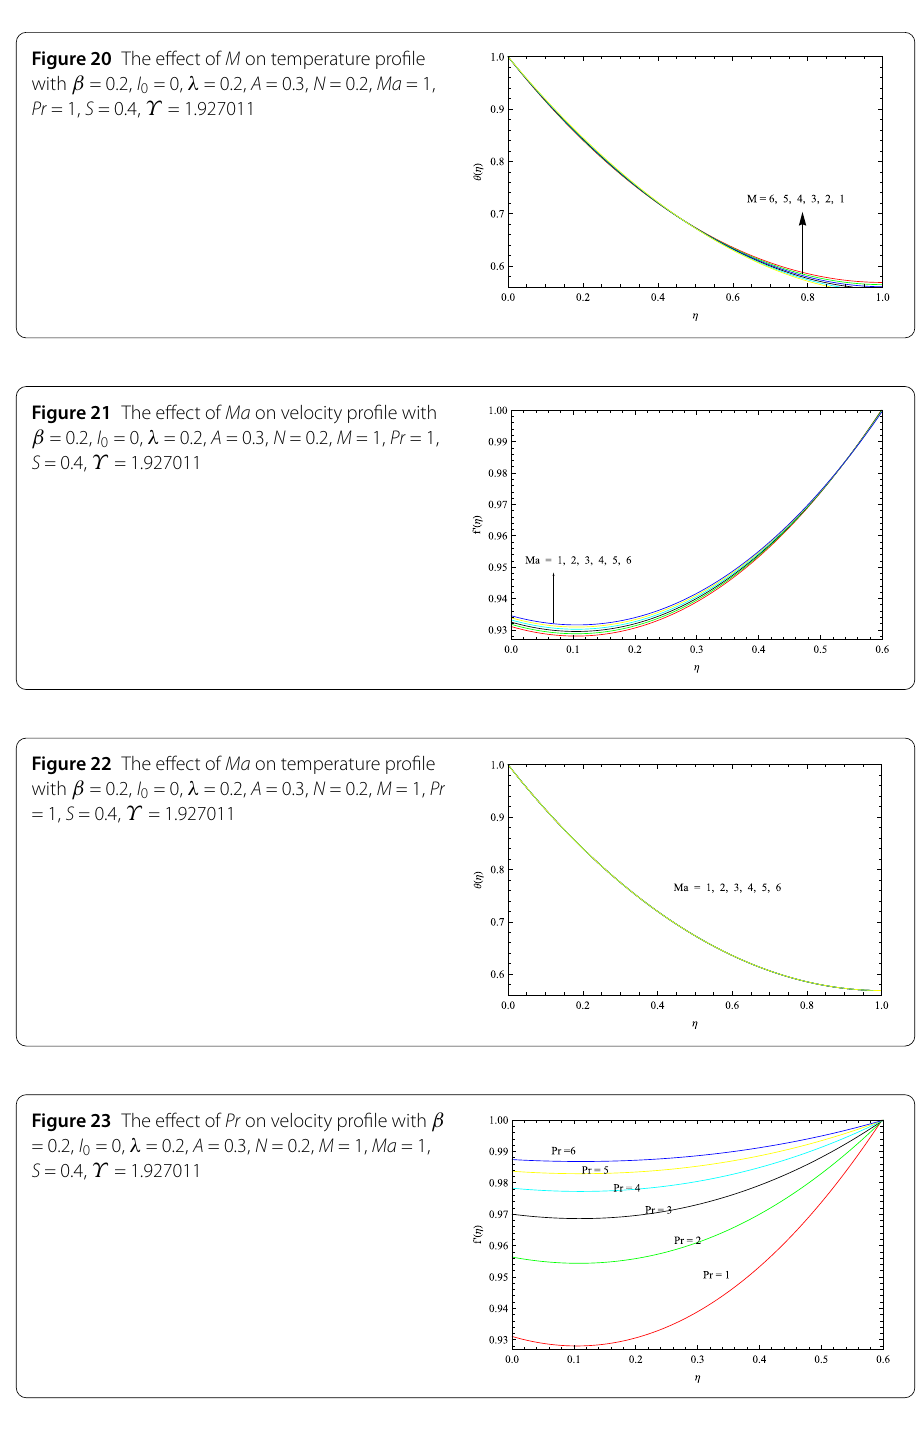
Figure 23 The effect of Pr on velocity profile with β = 0.2, I 0 = 0, λ = 0.2, A = 0.3, N = 0.2, M = 1, Ma = 1, S = 0.4, Υ =